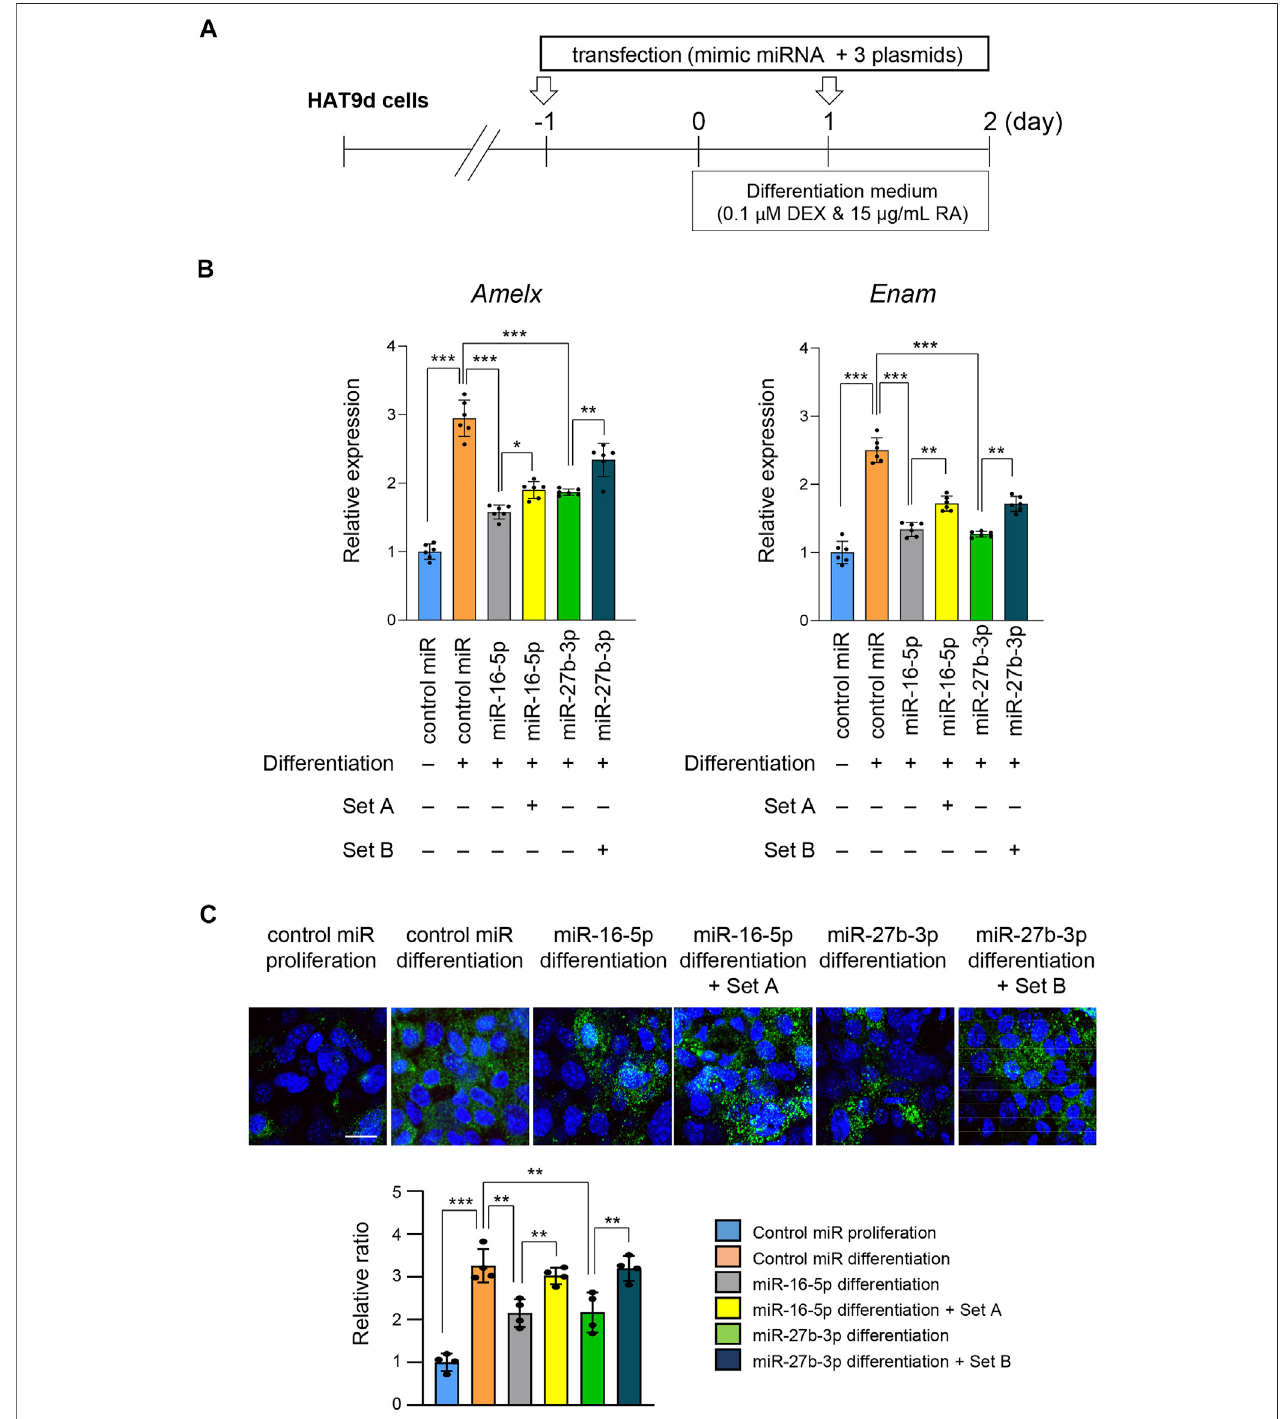
FIGURE 6 | Overexpression of target genes following overexpression of miR-16-5p and miR-27b-3p. (A) Schematic of the experiment. (B) Gene expression of Amelx and Enam following overexpression of Eda, Relt, and Smad3 under overexpression of control and miR-16-5p mimic, or of Bmp2, Pax9, and Slc24a4 under overexpression of control and miR-27b-3p mimic, in mHAT9d cells ( n = 6). * p < 0.05; ** p < 0.01; *** p < 0.001. (C) ICC for AMELX in mHAT9d cells under the indicated conditions. Scale bar, 50 μ m. Graph shows the quanti fi cation of images from four independent experiments. ** p < 0.01; *** p < 0.001.